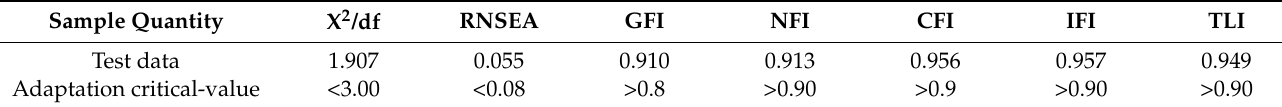
Table 8. Fitting coefficient of structural